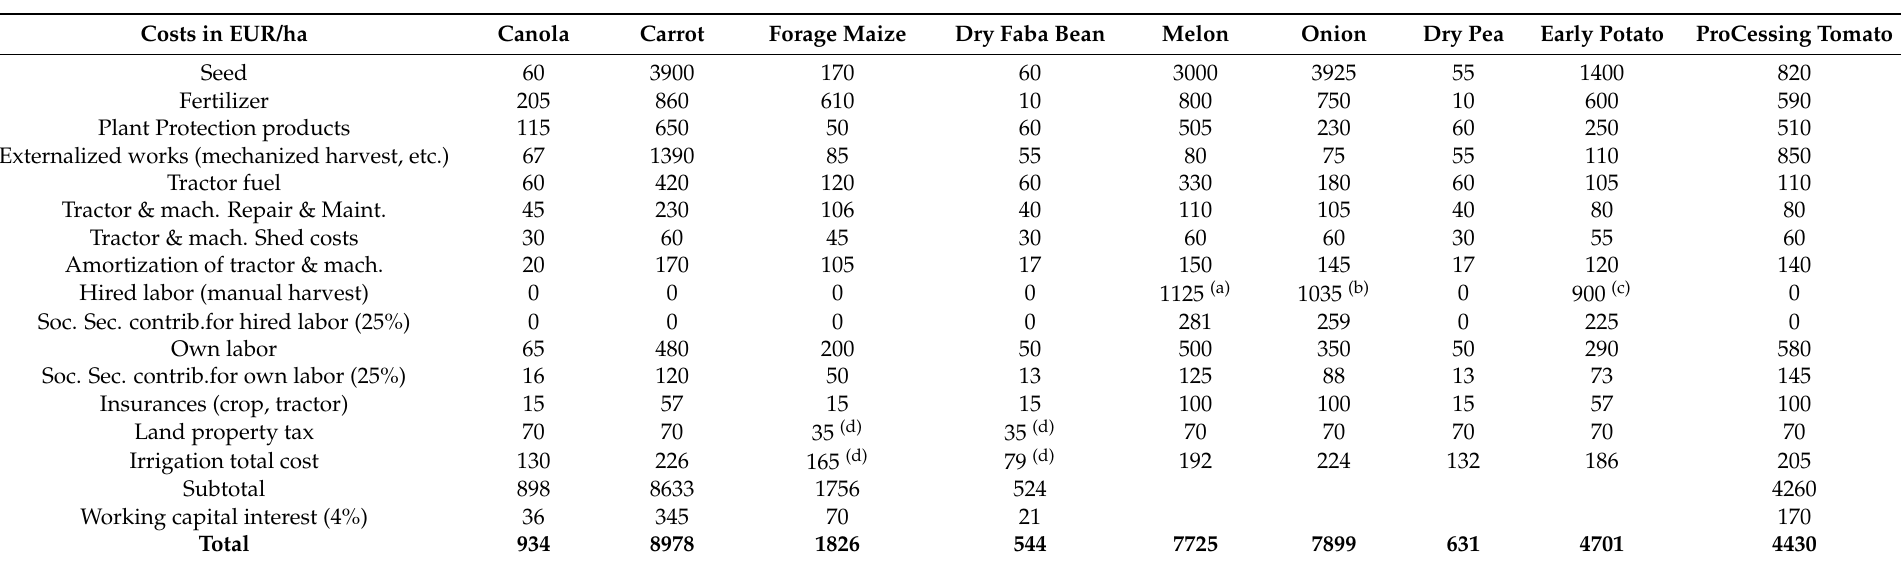
Table A4. Annual production costs for the 9 crops under full sunlight. Values adapted from